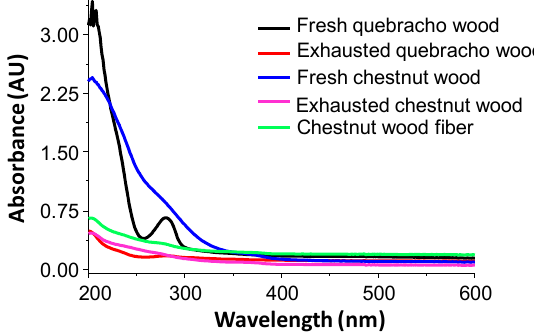
Figure 7. UV-Vis spectra of wood samples (0.2 mg / mL) in water.